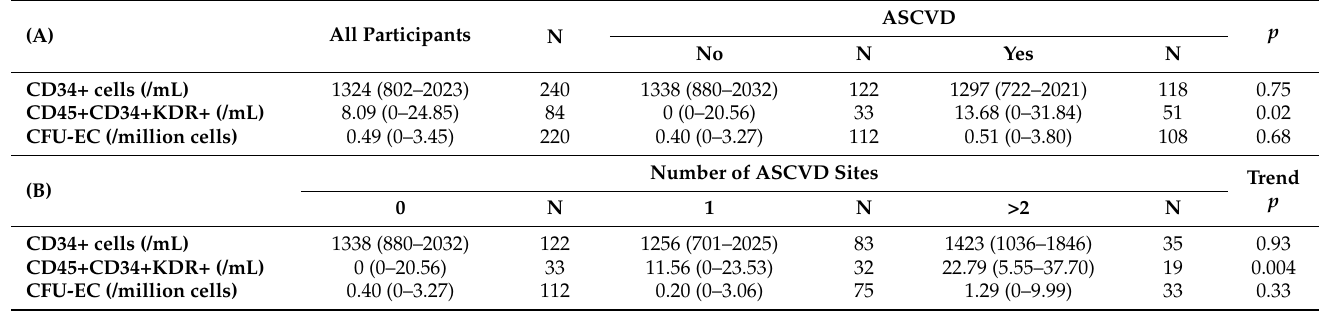
Table 2. Circulating progenitor cell subpopulations according to ASCVD presence and severity